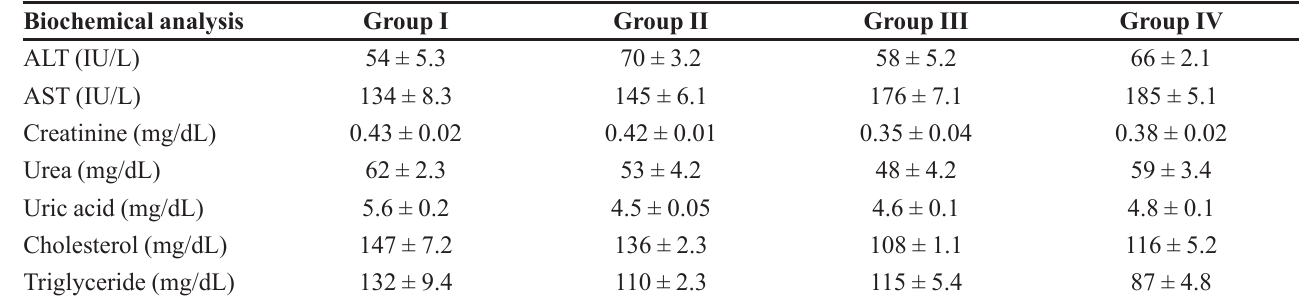
ALT: alanine aminotransferase, AST: aspartate aminotransferase. All values are expressed as mean ± S.D. TABLE V - Absolute mean organ weight (g) of mice after oral administration of LSH Organ Group I Group II